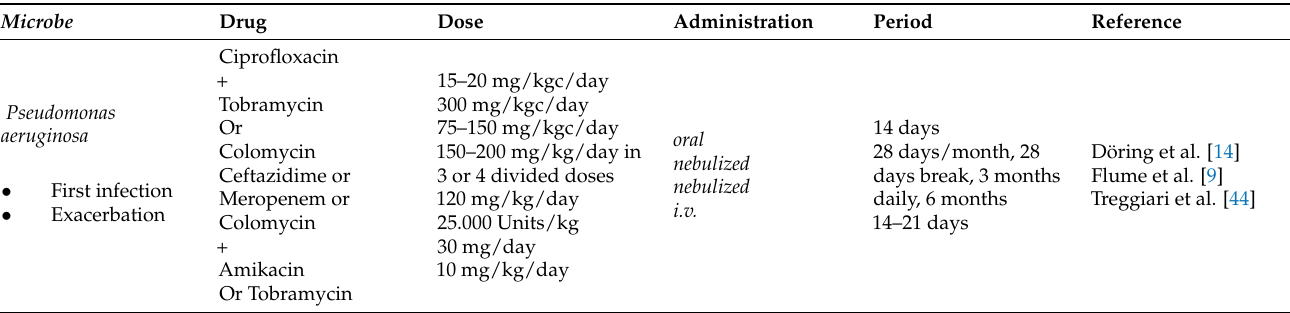
Table 1. Recommended antibiotics for Pseudomonas aeruginosa infection in CF patients. Administration Period